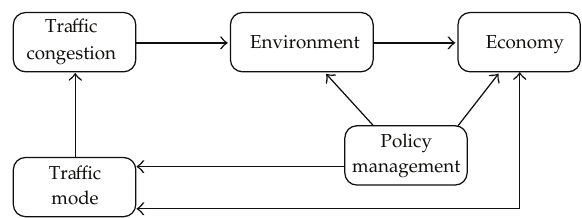
Figure 1: The subsystems of garden city transportation